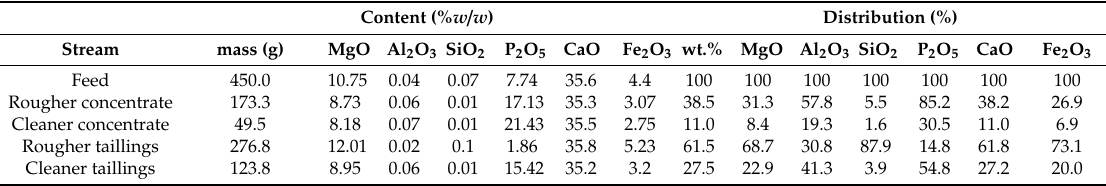
Table 7. Results of reverse flotation of apatite from the deslimed CC